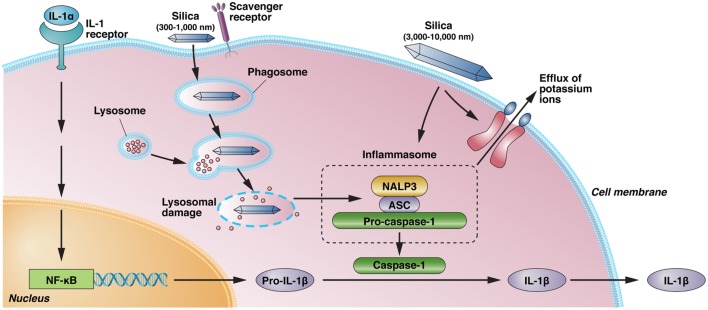
Silica-induced activation of inflammasome and IL-1 production. IL-1α, released from alveolar macrophages following crystalline exposure, results in NF-κB activation and transcription and translation of pro-IL-1β. Phagocytosis of crystalline silica leads to phagosomal damage and release of phagosome contents into the cytoplasm. This results in the activation of NALP3 and its association with the intracellular adapter protein ASC, which combines with and activates pro-caspase-1. The resulting inflammasome cleaves pro-IL-1β to the proinflammatory IL-1β. However, binding of immobilized silica crystals to the cell membrane of macrophages is also sufficient to induce IL-1β without evidence of lysosomal damage. Activation of the NALP3 inflammasome by silica also results in efflux of intracellular potassium ions, suggesting a possible interaction of silica with a membrane-associated protein, but it is unclear if K+ efflux following binding of immobilized silica crystals to the cell membrane results in inflammasome activation. Scavenger receptors have a role in the recognition and uptake of silica. NALP3, NACHT, LRR, and PYD domains-containing protein 3; ASC, apoptosis-associated speck-like protein containing a caspase recruitment domain; NF-κB, nuclear factor-κB; IL, interleukin.